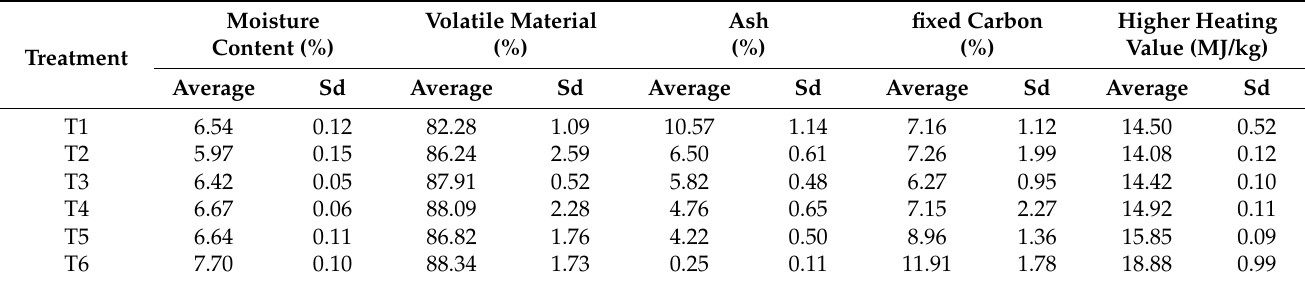
Table 2. Proximal analysis of Agave durangensis fibers and Pine spp. sawdust mixtures (Sd = standard deviation).